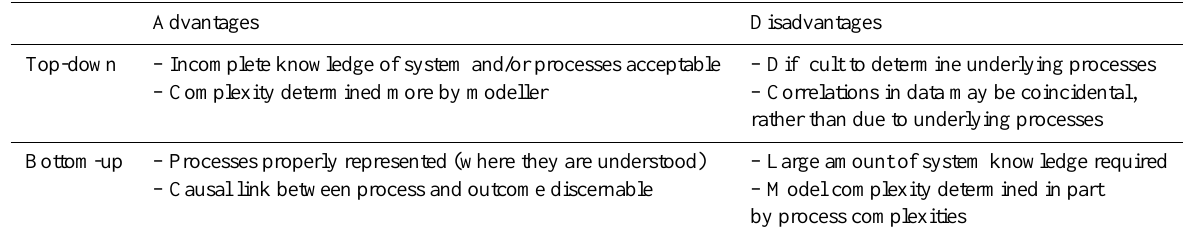
Table 3. Key advantages and disadvantages of top-down and bottom-up modelling techniques.